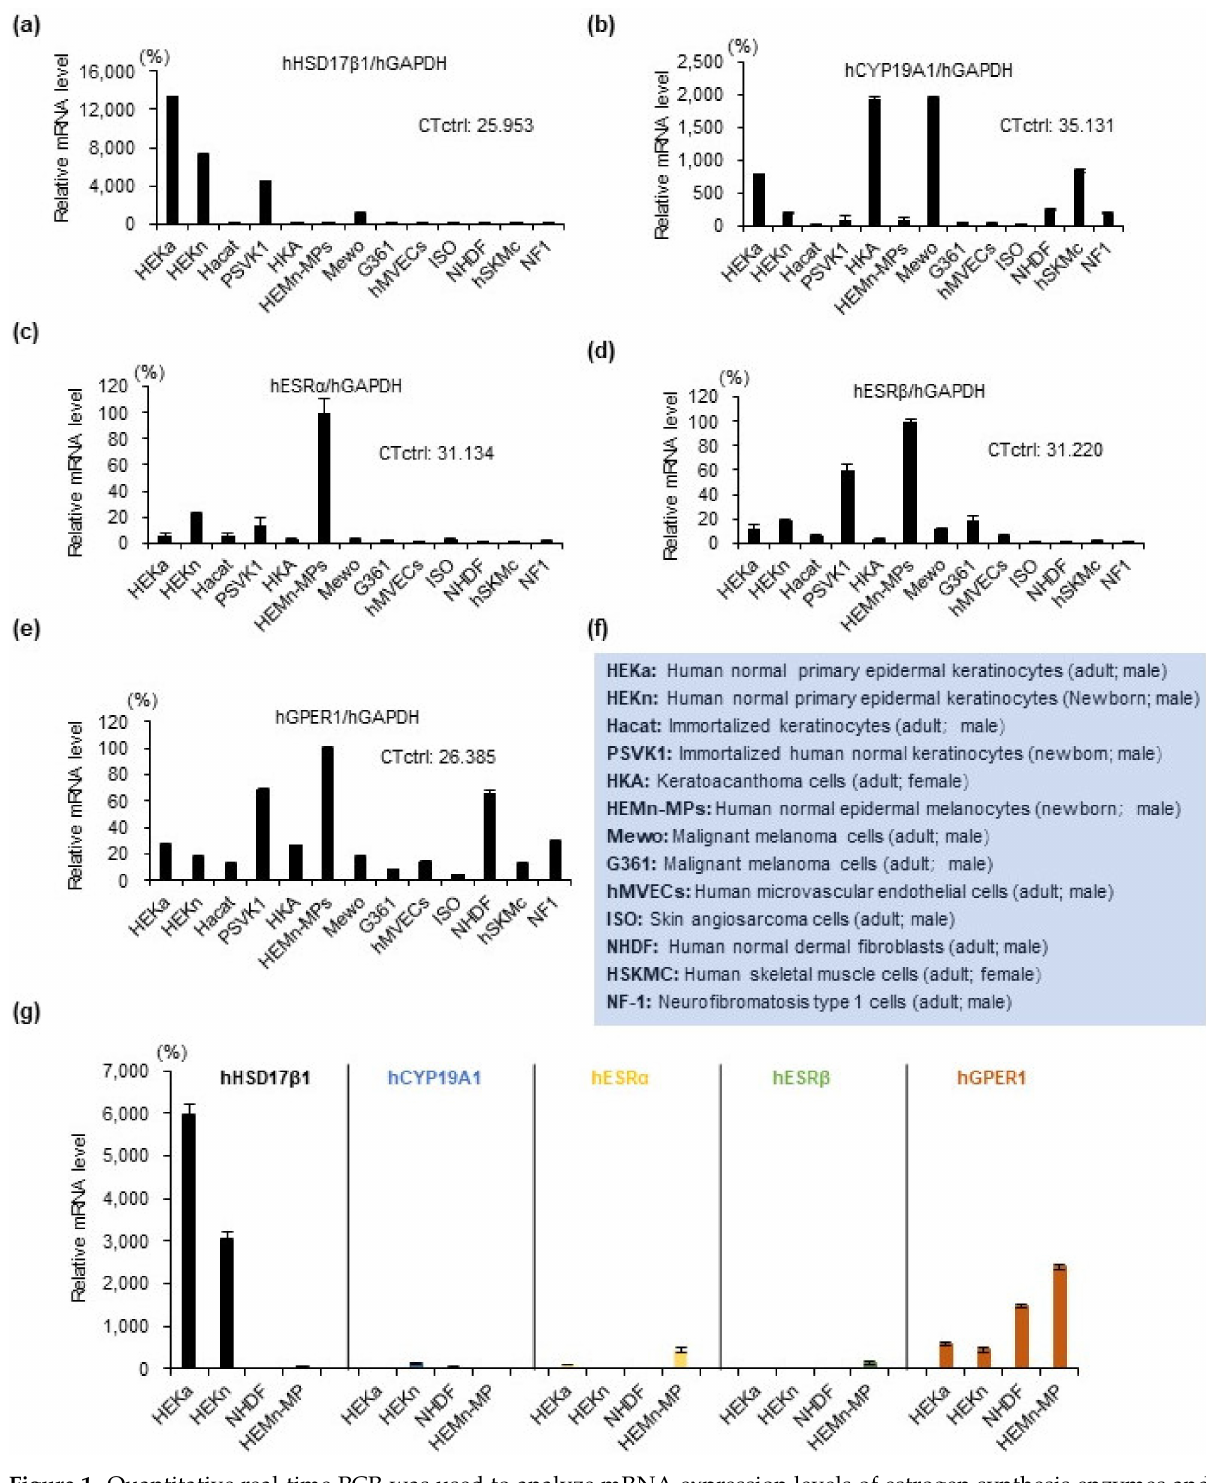
Figure 1. Quantitative real-time PCR was used to analyze mRNA expression levels of estrogen synthesis enzymes and receptors in 13 types of skin cells. ( a ) Relative mRNA expression level of estrogen synthesis enzyme hHSD17 β 1; ( b ) relative mRNA expression level of estrogen synthesis enzyme hCYP19A1; ( c ) relative mRNA expression level of estrogen receptor hESR α ; ( d ) relative mRNA expression level of estrogen receptor hESR β ; ( e ) relative mRNA expression level of estrogen receptor hGPER1; ( f ) information on skin cells; ( g ) mRNA expression levels of estrogen synthesis enzymes and receptors in the indicated cell lines. mRNA expression levels were normalized to glyceraldehyde-phosphate-dehydrogenase (GAPDH). Data represent the results of three independent experiments. Data are shown as means ±